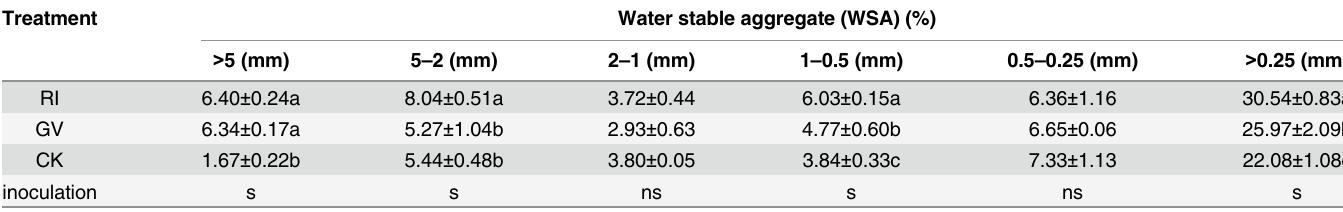
Table 4. Effect of AM fungi on the percentage of soil aggregate at different size in the rhizosphere of R . pseudoacacia . Treatment